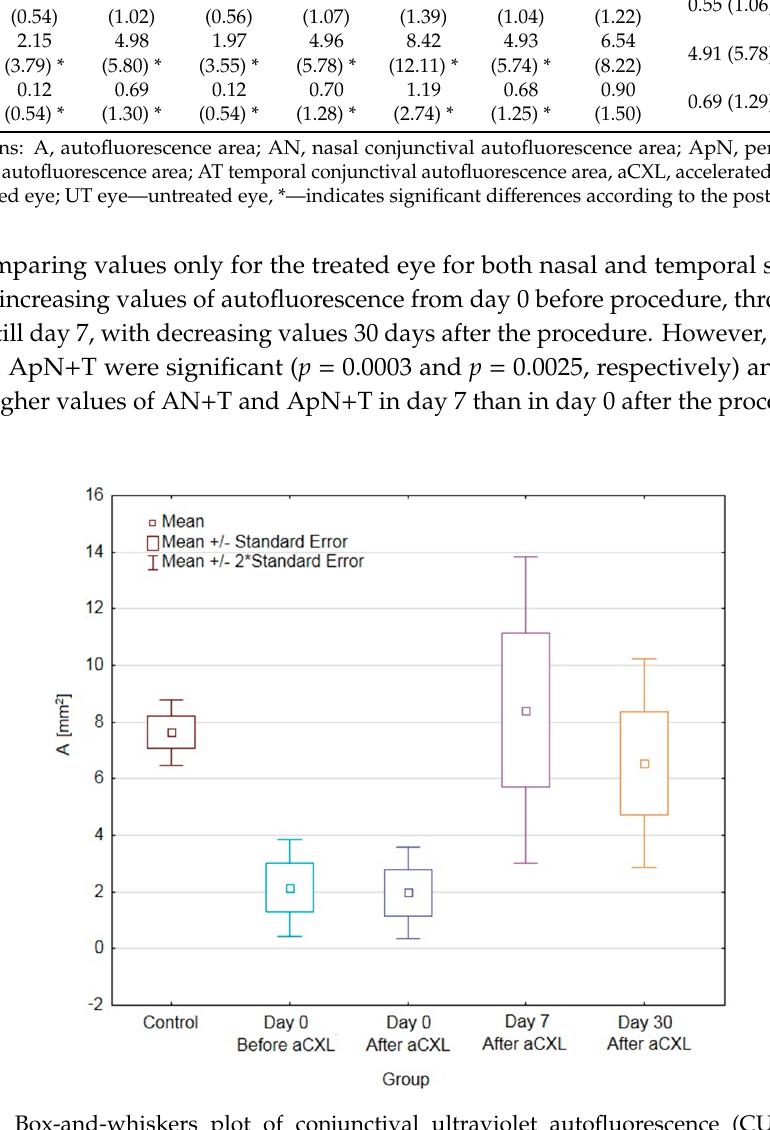
Figure 3. Box-and-whiskers plot of conjunctival ultraviolet autofluorescence (CUVAF) nasal and temporal perilimbal area (ApN+T) measurements in keratoconical eyes undergoing accelerated corneal cross-linking (aCXL) procedure and untreated keratoconical eyes as well as the eyes of control group patients. Abbreviations: CUVAF, conjunctival ultraviolet autofluorescence; ApN+T, nasal and temporal perilimbal conjunctival autofluorescence area; aCXL, accelerated corneal cross-linking.